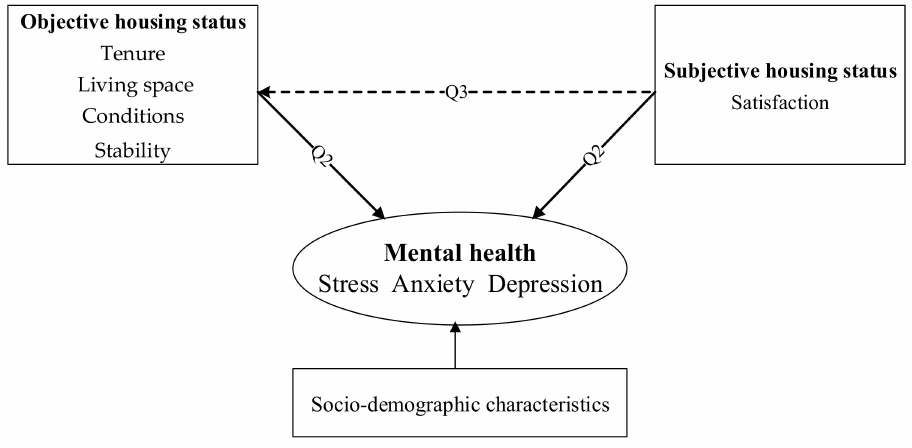
Figure 1. Conceptual